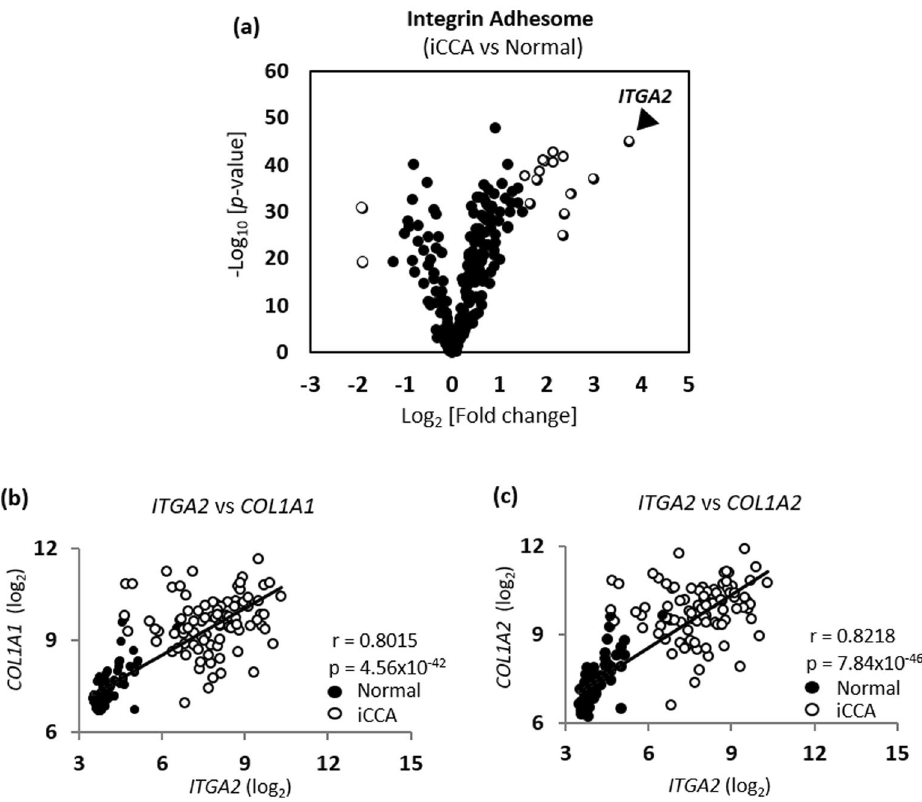
Figure 1. Aberrant ITGA2 upregulation is correlated with high collagen type I expression in iCCA tumors. ( a ) Volcano plot of the differentially-expressed integrin adhesome-related genes between iCCA tumors and their adjacent normal tissues from GSE76297 dataset (n = 91). Black dots indicate genes with no or low differential expression. White dots indicate genes with high differential expression (Log 2 FC ≥ 1.5 or Log 2 FC ≤ − 1.5). Co-expression of genes between either ( b ) ITGA2 and COL1A1, or ( c ) ITGA2 and COL1A2 from the same dataset were analyzed using Pearson’s r